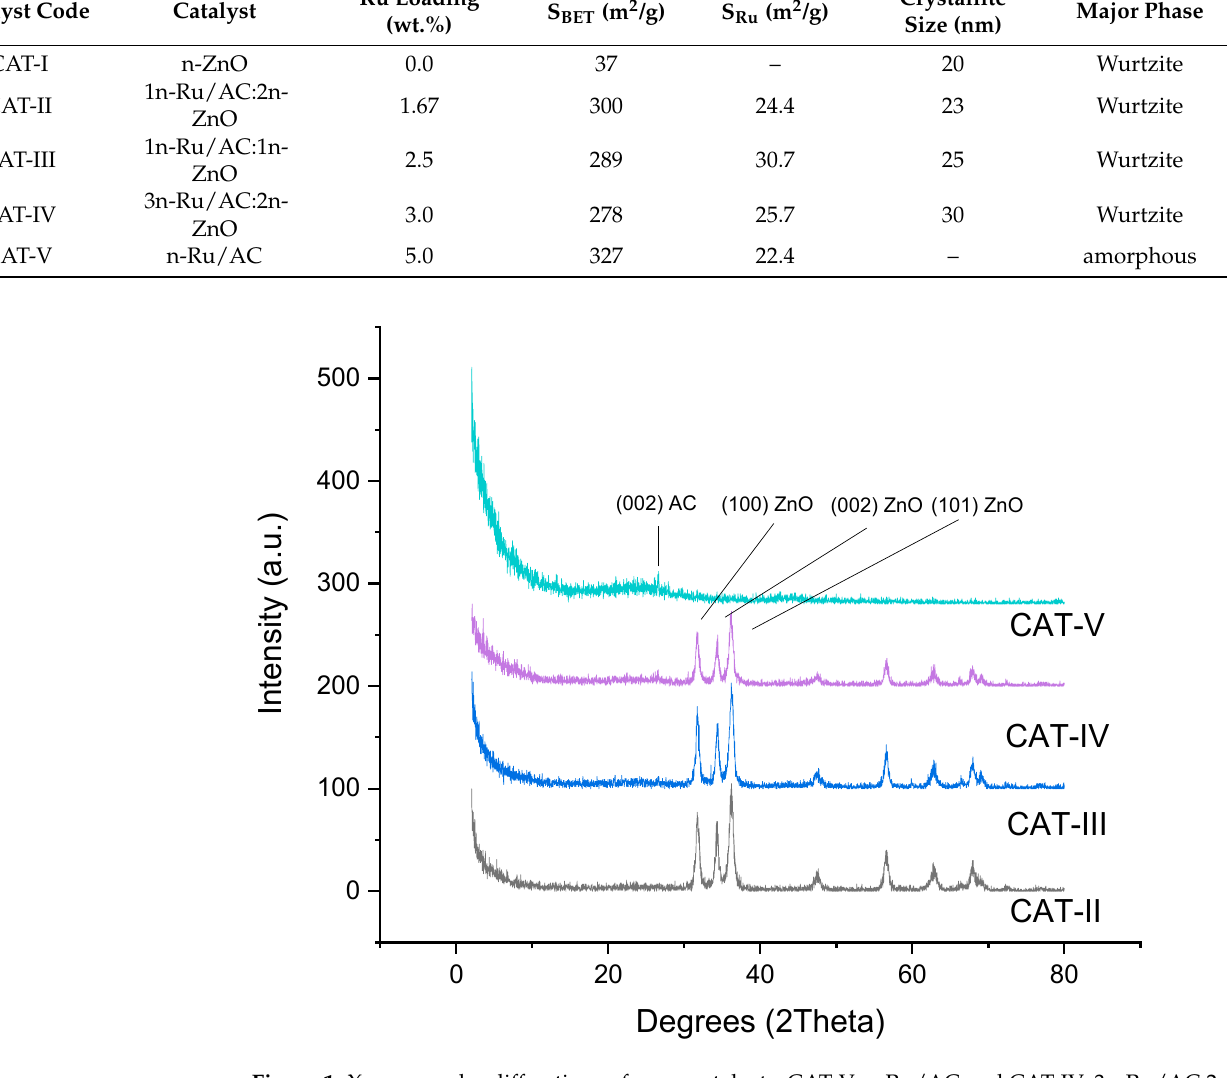
Figure 1. X-ray powder diffractions of some catalysts, CAT-V: n-Ru/AC and CAT-IV: 3n-Ru/AC:2n- ZnO [6]. Figure 2a,b show complementary pairs of fresh crystalline n -ZnO particles. There were crystalline particles with sizes between 20 and 30 nm rather than homogeneous sizes. Figure 2c,d show the amorphous nature of activated carbon and small ruthenium particles in the range of 3–4 nm.